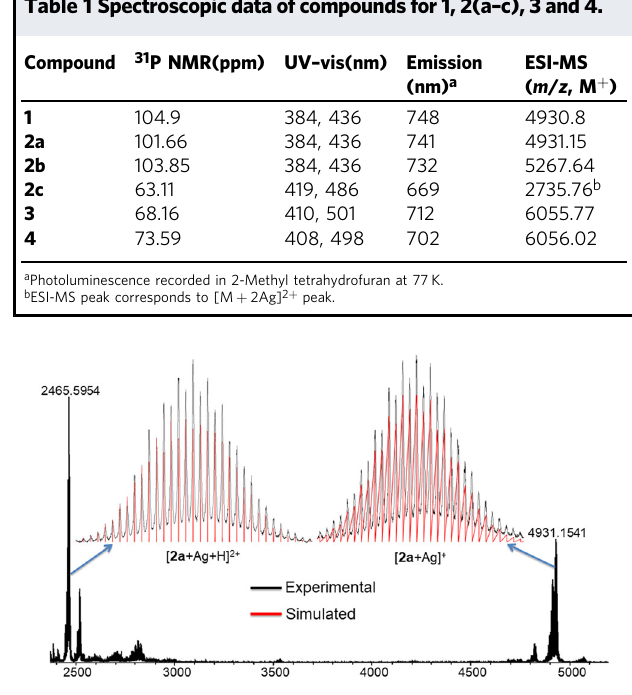
Fig. 2 Mass spectrometry. ESI-MS (Positive mode) of [ 2a + Ag] + . Insets: experimental (black) and simulated (red) mass